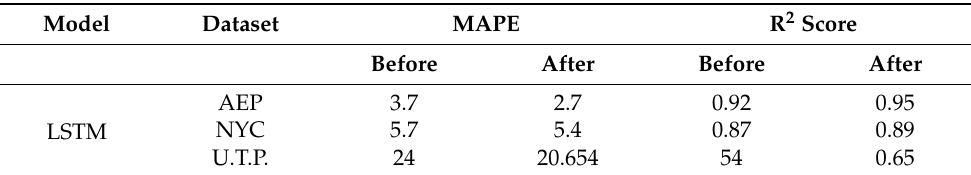
Table 5. LSTM model performance on A.E.P., N.Y.C., and U.T.P. datasets before and after paramet- ric variations.